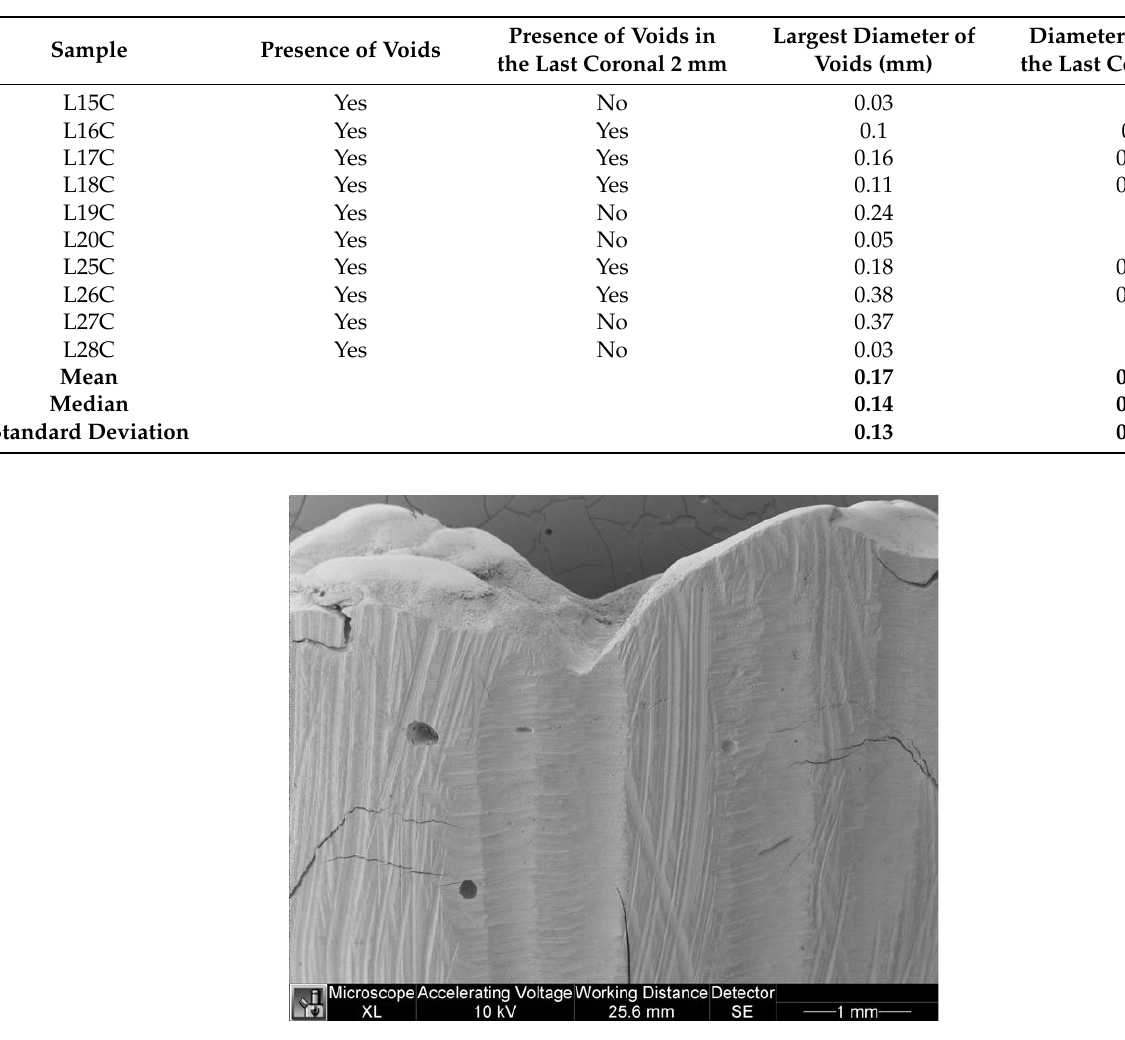
Table 8. Voids detected in the control group.